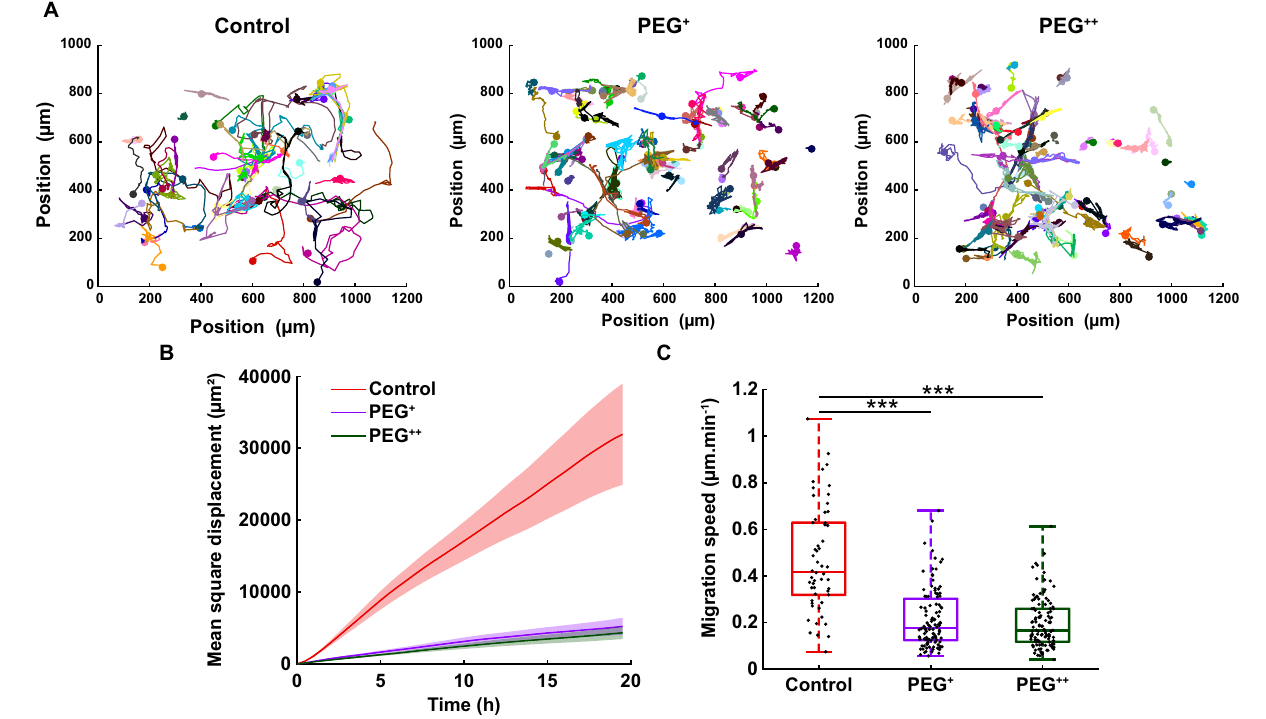
Figure 3. Increase in osmotic pressure strongly reduces cell migration. ( A ) Cell trajectories over the duration of the experiment (90 h), 3 biological repeats and N = 54, 111 and 118 for the control, PEG + and PEG ++ groups, respectively. Each color represents the path of one cell. ( B ) Mean square displacement of the first 20 h of the cell cycle (MSD, in µm 2 ). The thick line represents the average MSD and the shadow is the standard deviation. ( C ) Migration speed (µm min −1 ) of single cells taken as the median of instantaneous cell speeds over their trajectories. The plots represent the median, 1st and 3rd quartiles and extrema. Statistical analysis with respect to the control using a two-tailed Wilcoxon rank sum test, n.s: p > 0.05, *: p < 0.05, **: p < 0.01 and ***: p <